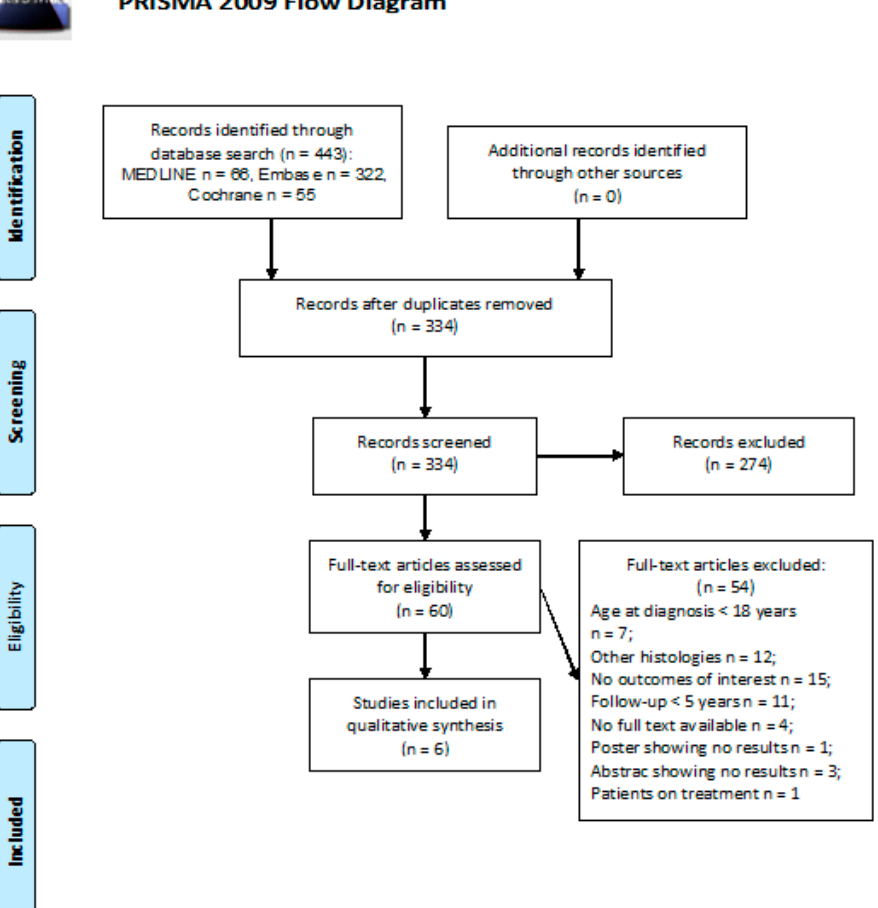
Figure 6. PRISMA flow diagram on the incidence of anxiety and depression.